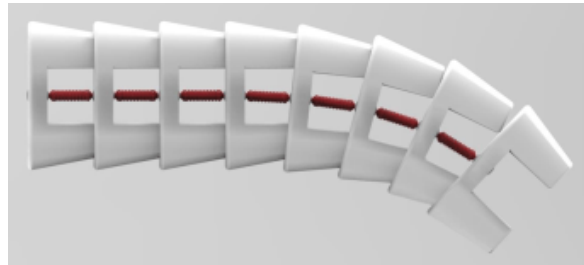
Figure 8. Section view of the springs and joints of one segment